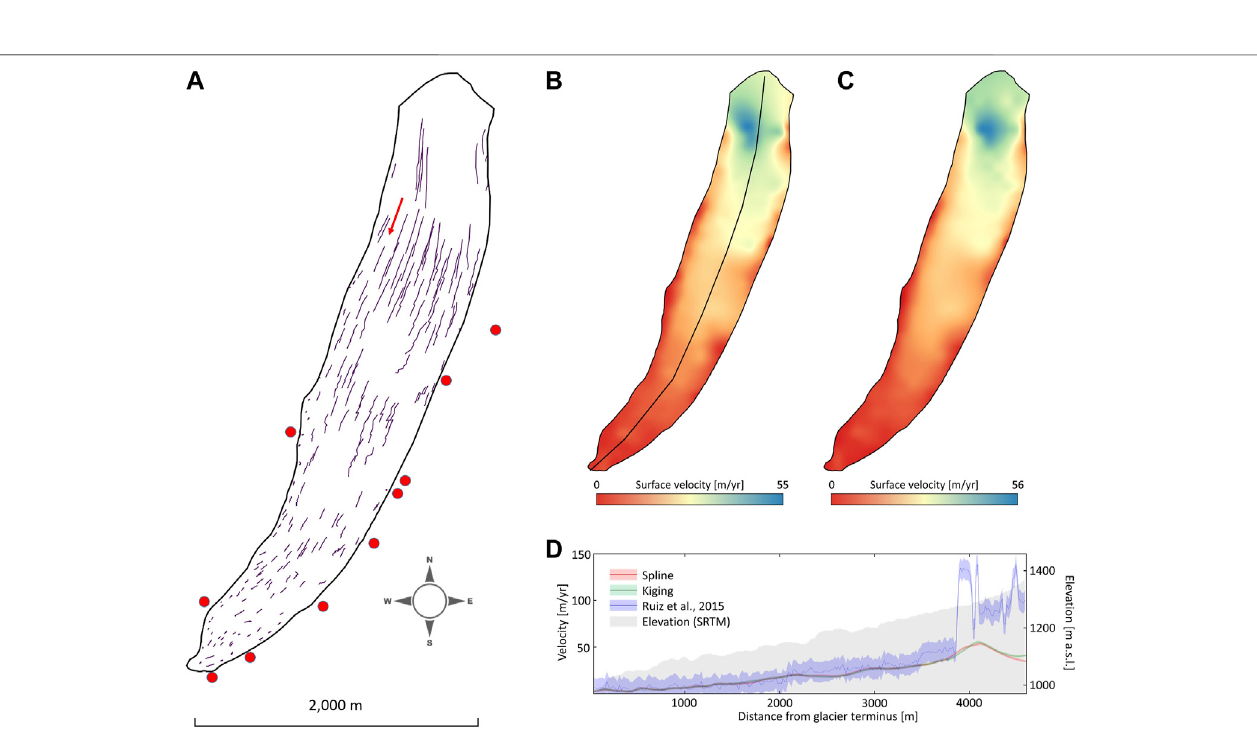
FIGURE6|(A) Trackedbouldersonthedebris-coveredtongueofVerdeglacierbetweenNovember 2009andOctober2019.Theredarrowshowsthelocationof the boulder of Figure 2 . Red dots mark the location of control points outside glacier area (B, C) Interpolated surface velocity using spline and kriging interpolation